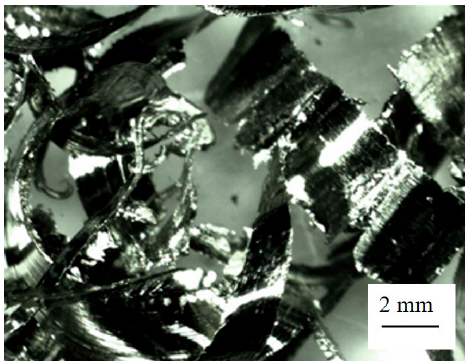
Figure 1. UNS S31803 stainless steel duplex scrap.